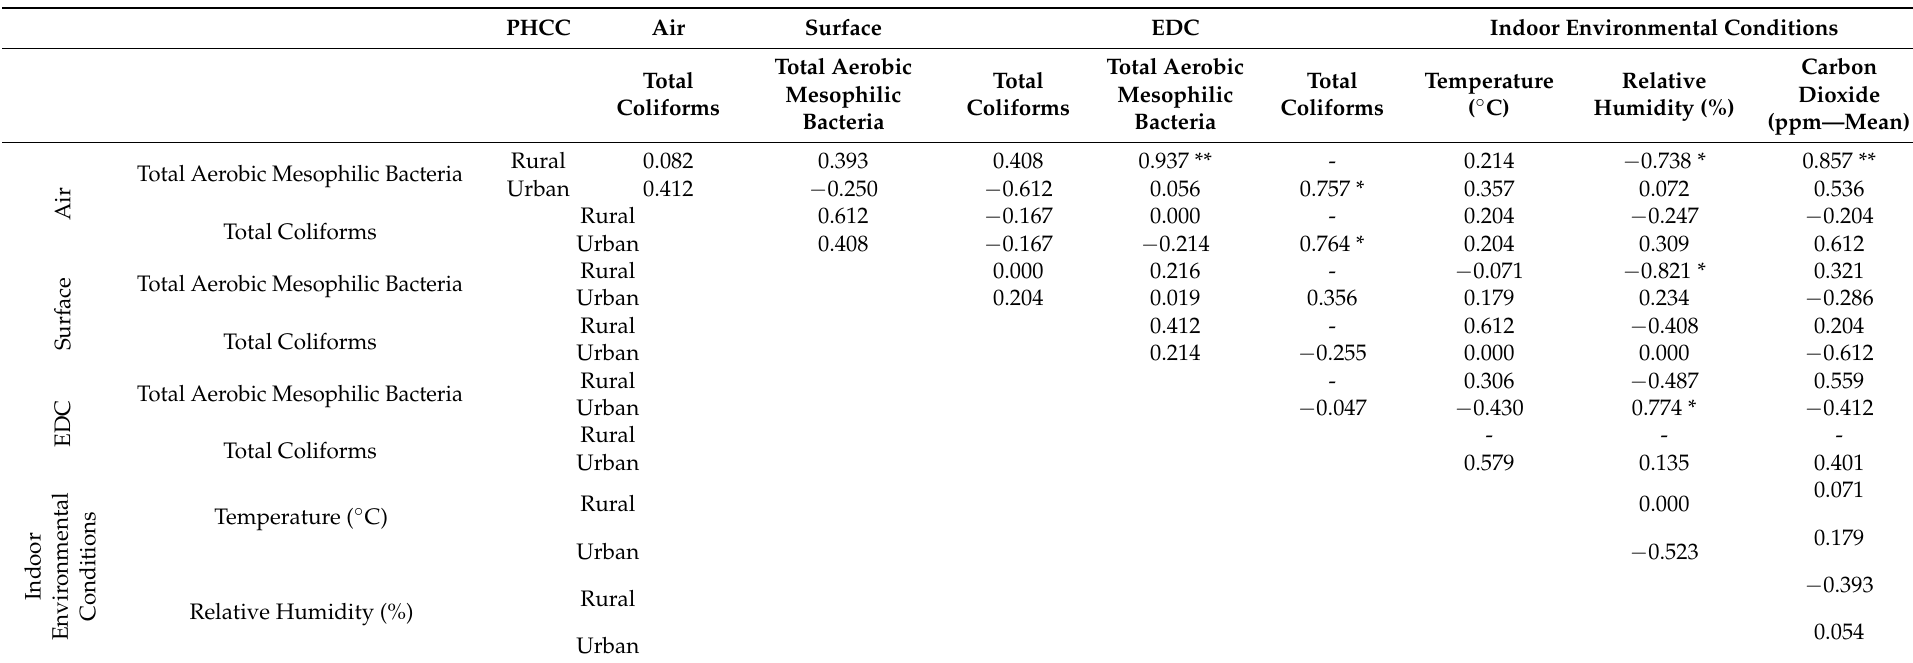
Table 5. Study of the relationship between total aerobic mesophilic bacteria, total coliforms (in air, surface and EDC) and environmental conditions (temperature, relative humidity and carbon dioxide concentration) in a rural and urban PHCC: results from Spearman’s correlation